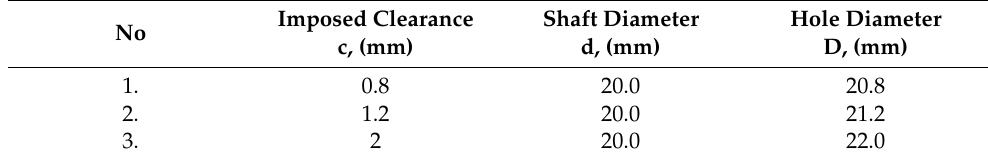
Table 1. Dimensions of the designed samples.